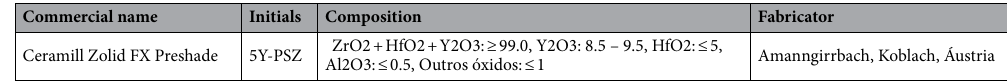
Table 3. Commercial name, acronym, composition and manufacturer of the materials used to make the